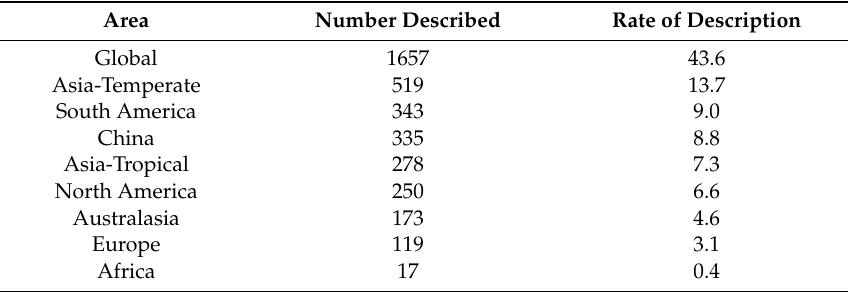
Table 2. Rate of stonefly species descriptions 1980 to 2018. Area Number Described Rate of